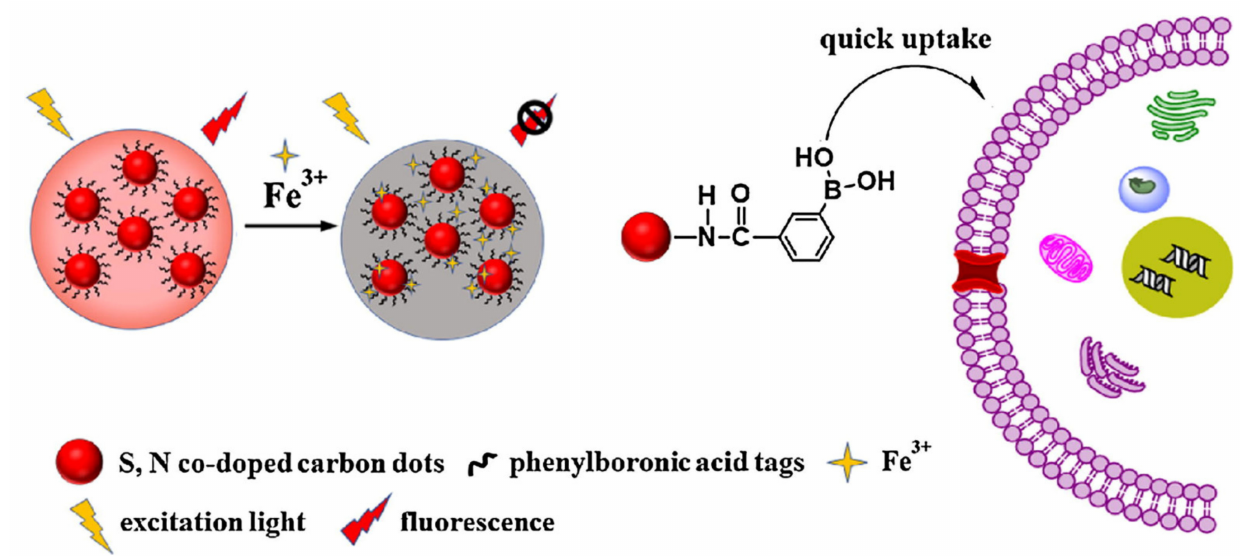
Figure 11. Schematic diagram of N, S-CDs-PBA sensing Fe 3+ in PC12 cells